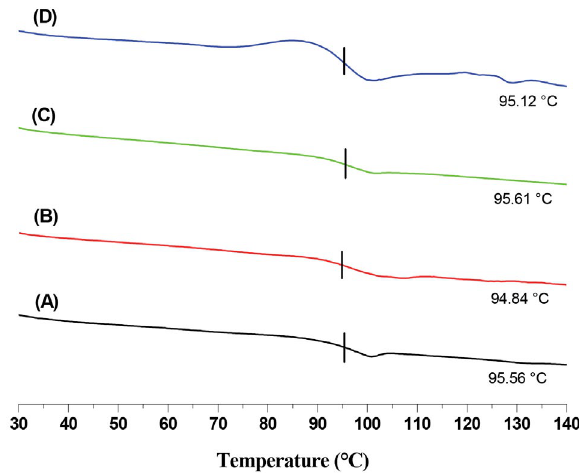
Figure 1: DSC thermograms of (A) neat PS, (B) 5 wt.% magnesia reinforced PS, (C) 10 %.wt magnesia reinforced PS, and (D) 15 wt.% magnesia reinforced